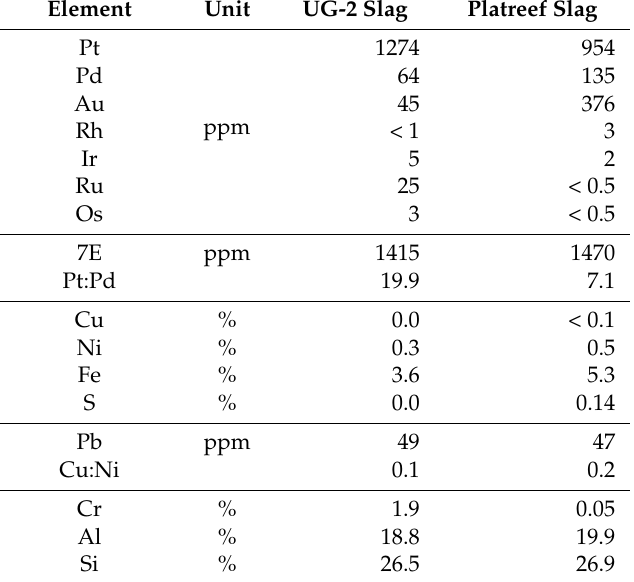
Table 7. Precious-metal and base-metal contents of 3 slag samples resulting from the smelting process. Note the variation in PGE contents. The Al content gives an indication of the amount of refractory included in the analysis (the crucible consists of an Al-Si